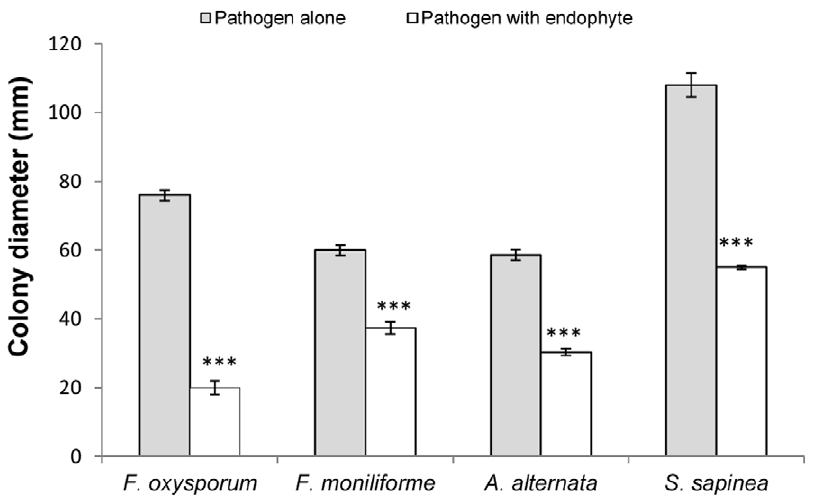
Figure 1. Antagonism observed in dual culture of P.variabile with different strains of phytopathogens. Colonies diameters of different phytopathogens strains were measured at day fourteen in absence (gray) or in presence (white) of the endophyte P. variabile . Error bars indicate standard deviation (n=3). Asterisks indicate a statistically significant decrease of the growth of the phytopathogen in the presence of the endophyte by t-test (***p , 0.001).